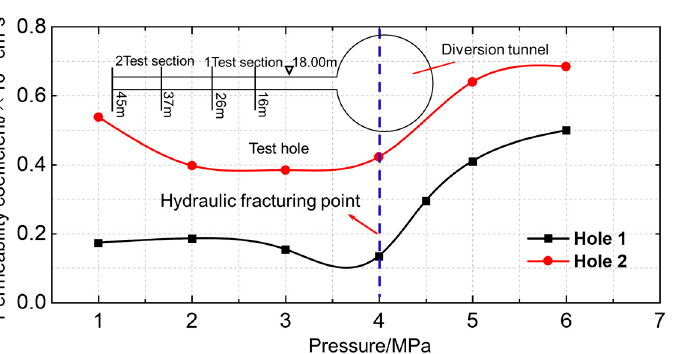
Figure 13. Relation curve between permeability coefficient and hydraulic pressure [77].